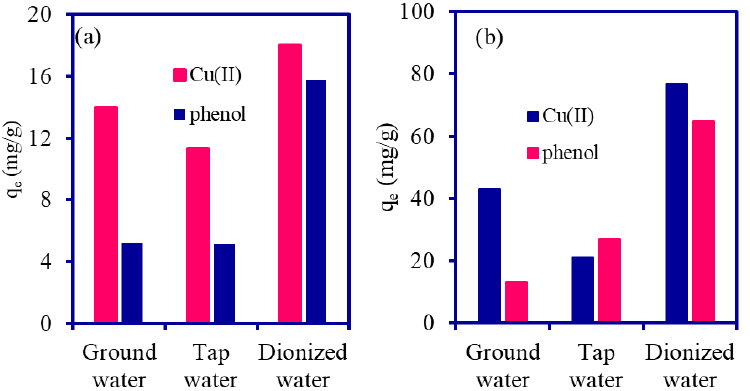
Figure 9. Adsorption of Cu(II) and phenol from synthetic tap and groundwater using PANI@WTP ( a ) 20 mg/L and ( b ) 100 mg/L (volume, 20 mL; adsorbent mass, 0.02 g; pH 5 for phenol, 5.2 for Cu(II); temp, 30 °C).